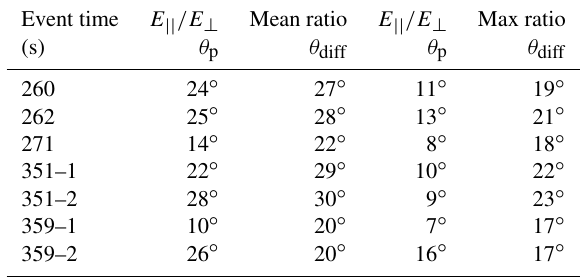
Table 2. The resulting angles θ from Eq. (3) for the mean and max- imum ratios defined in Table 1 for both the plasma line ( θ p ) and diffuse feature ( θ diff